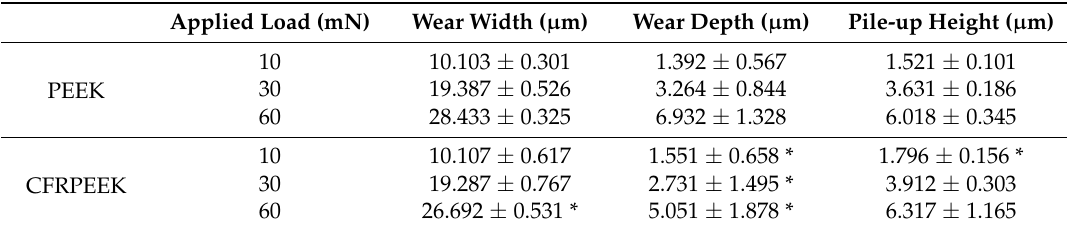
Figure 5. 3D profile micrographs of the worn surfaces on the PEEK (left) and CFRPEEK (right) discs at different applied load: ( a ) progressive load with an initial load of 0.3 mN and a final load of 60 mN, ( b ) constant load of 10 mN, ( c ) constant load of 30 mN, and ( d ) constant load of 60 mN. The midline profile of each wear track in the sliding direction was displayed in the left bottom. Table 3. Measurement of nanowear tracks for PEEK and CFRPEEK after the nanoscratch tests. * p < 0.05, statistically significant difference, PEEK versus CFRPEEK in the same experimental conditions.